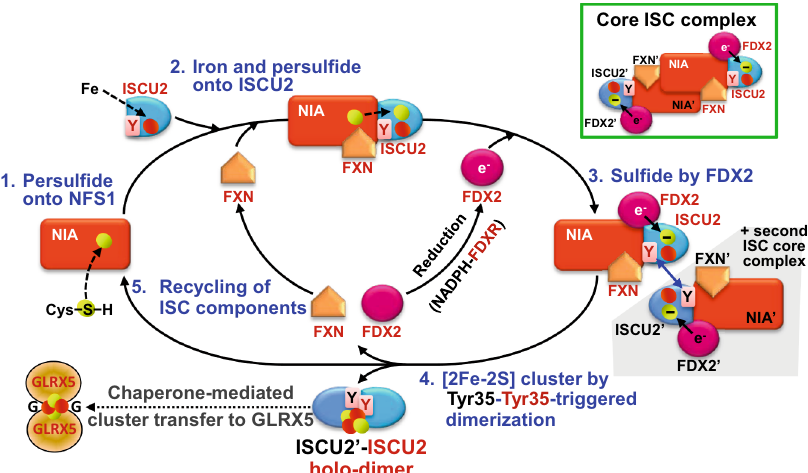
Fig. 7 Mechanistic working model for the reaction cycle of [2Fe-2S] cluster formation on an ISCU2 dimer by the mitochondrial core ISC complex. For simplicity, only one half of the symmetrical core ISC complex (green box, upper right) is shown in the reaction cycle. The steps are: 1. A persul fi de is generated in a PLP-dependent fashion on a fl exible Cys-containing loop of NFS1 (as part of the (NIA) 2 complex). 2. Upon binding of Fe-loaded ISCU2 and FXN to NFS1, the persul fi de is rapidly transferred from NFS1 to an active-site Cys of ISCU2. 3. Binding of reduced FDX2 assists the reduction of persul fi de sulfur to sul fi de ( ˗ ). 4. Tyr35-mediated dimerization of two (Fe and S ion-binding) ISCU2 proteins on different core ISC complexes yields a bridging [2Fe- 2S] cluster on an ISCU2 dimer. 5. Finally, the [2Fe-2S] cluster is further transferred to glutaredoxin 5 (GLRX5) in chaperone-dependent fashion, and (NIA) 2 , FXN, oxidized FDX2, and apo-ISCU2 are recycled for the next synthesis round. Red and yellow circles, iron and sulfur; Y, Tyr35; e - , reducing electron on